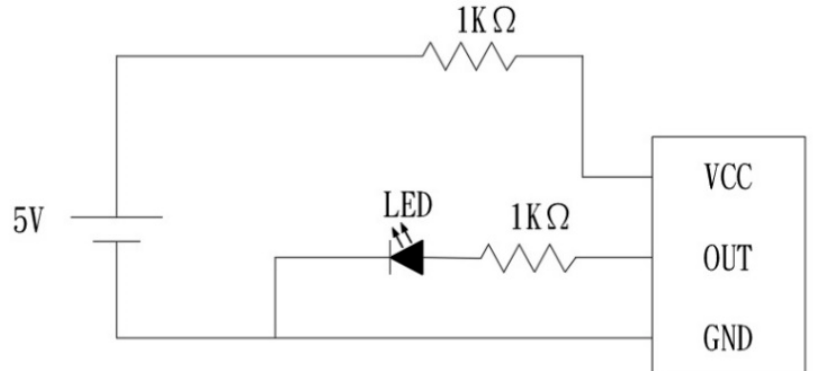
Figure 15. The circuit diagram of a warm body sensor.